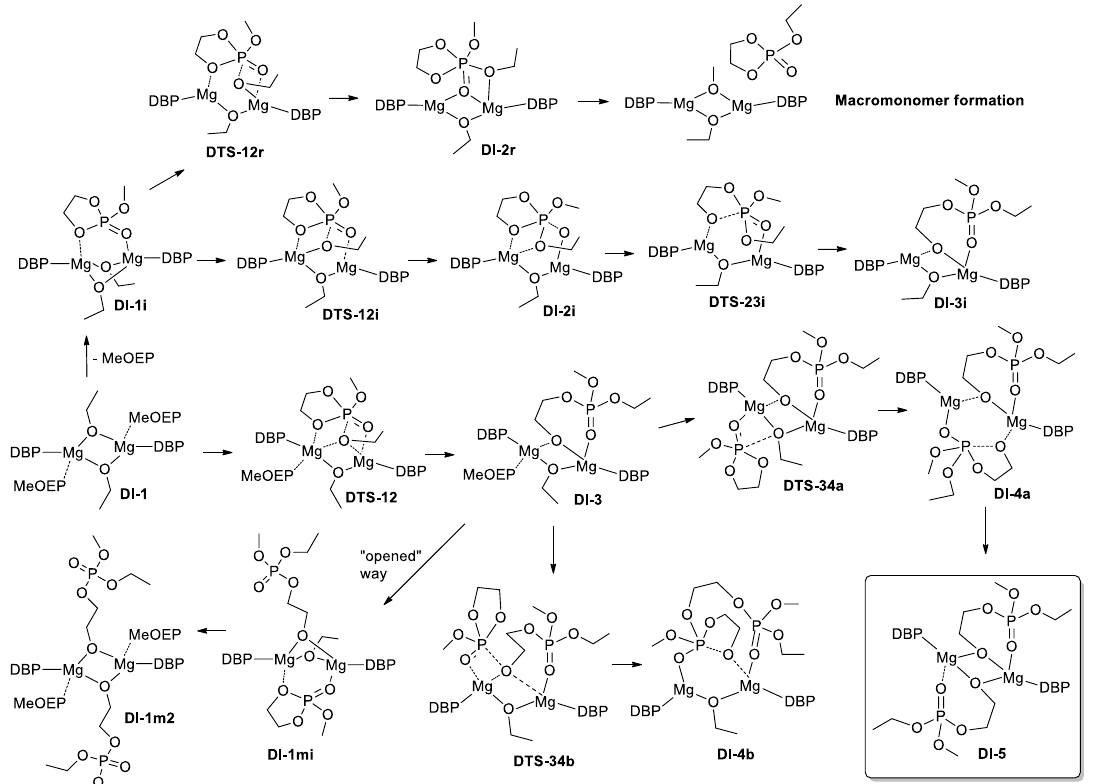
Scheme 4. Key intermediates and transition states of the initiation stage of MeOEP ROP catalyzed by the binuclear DBP-Mg complexes. 226 the binuclear DBP-Mg